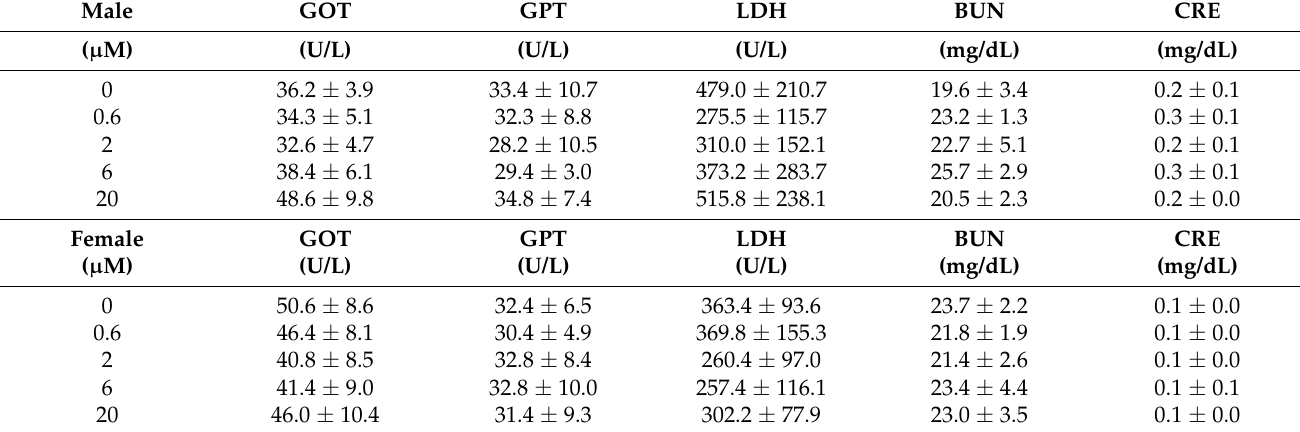
Table 2. Serum biochemistry changes in liver and renal function of ICR mice after feeding a single dose of FANC for 14